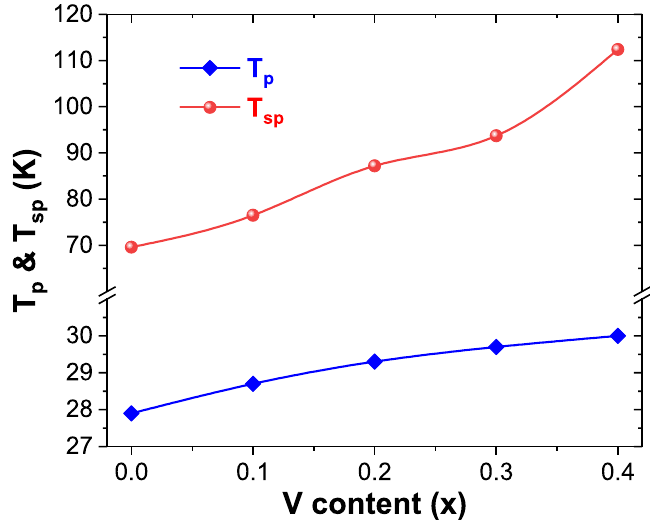
Figure 9. Variations in T p and T sp temperatures versus vanadium content.